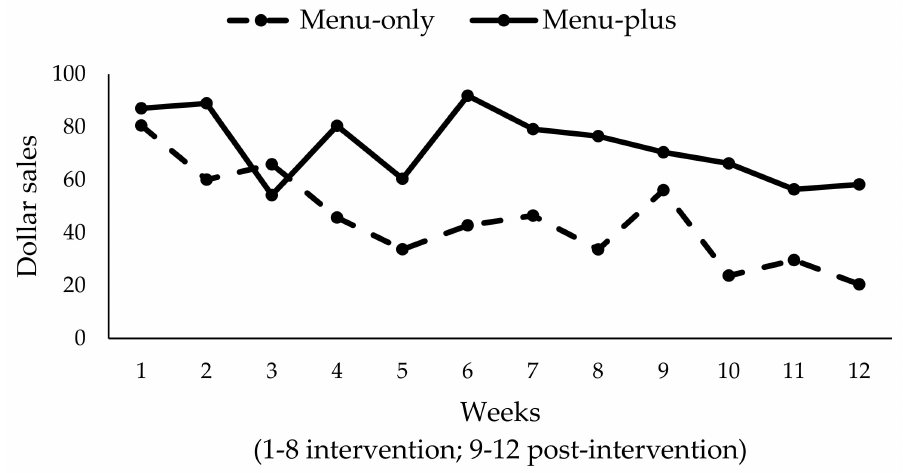
Figure 3. Total weekly $ sales of new healthy child menu items by condition ( N = 8).